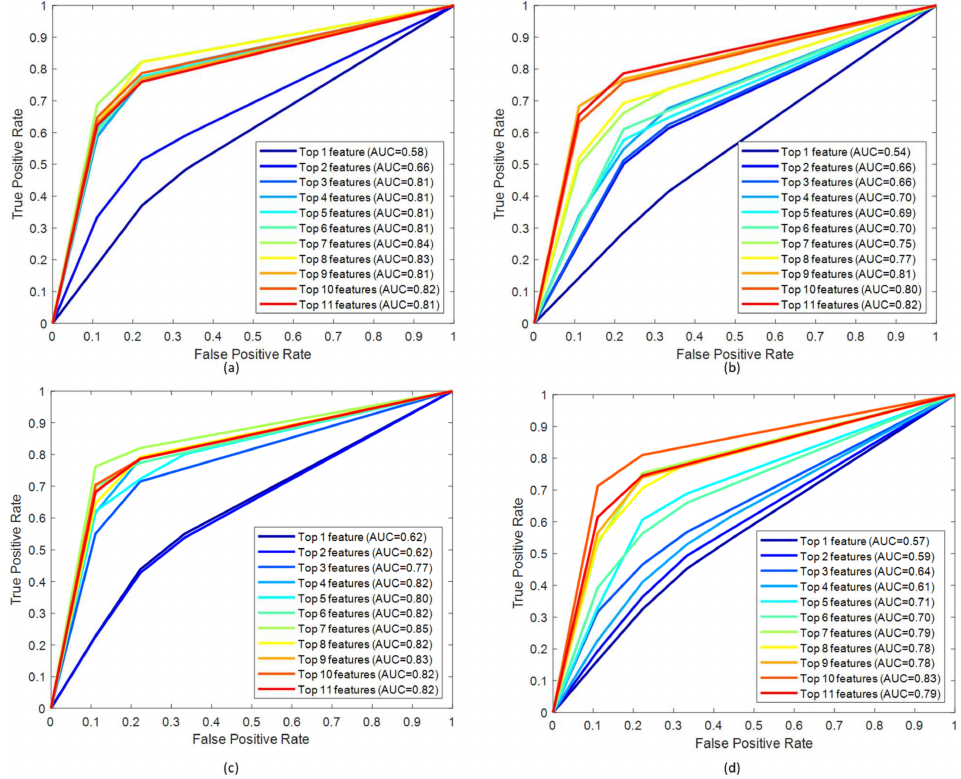
Figure 6. ROC curve for top-ranked features from the GL muscle EMG signal by ( a ) Chi-Square, ( b ) mrmr, ( c ) Relieff, ( d ) fscnca feature selection